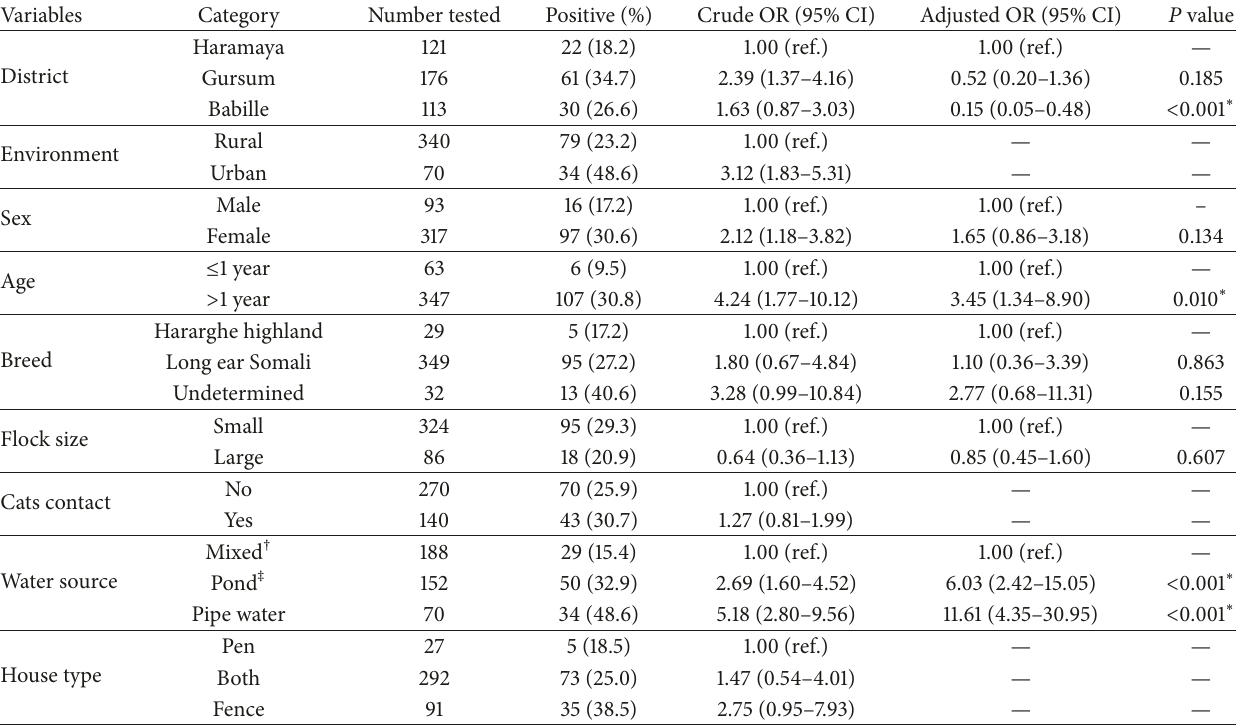
Table 3: Logistic regression analysis of risk factors with T. gondii seropositivity in goats at animal level ( 𝑛 = 410 ).